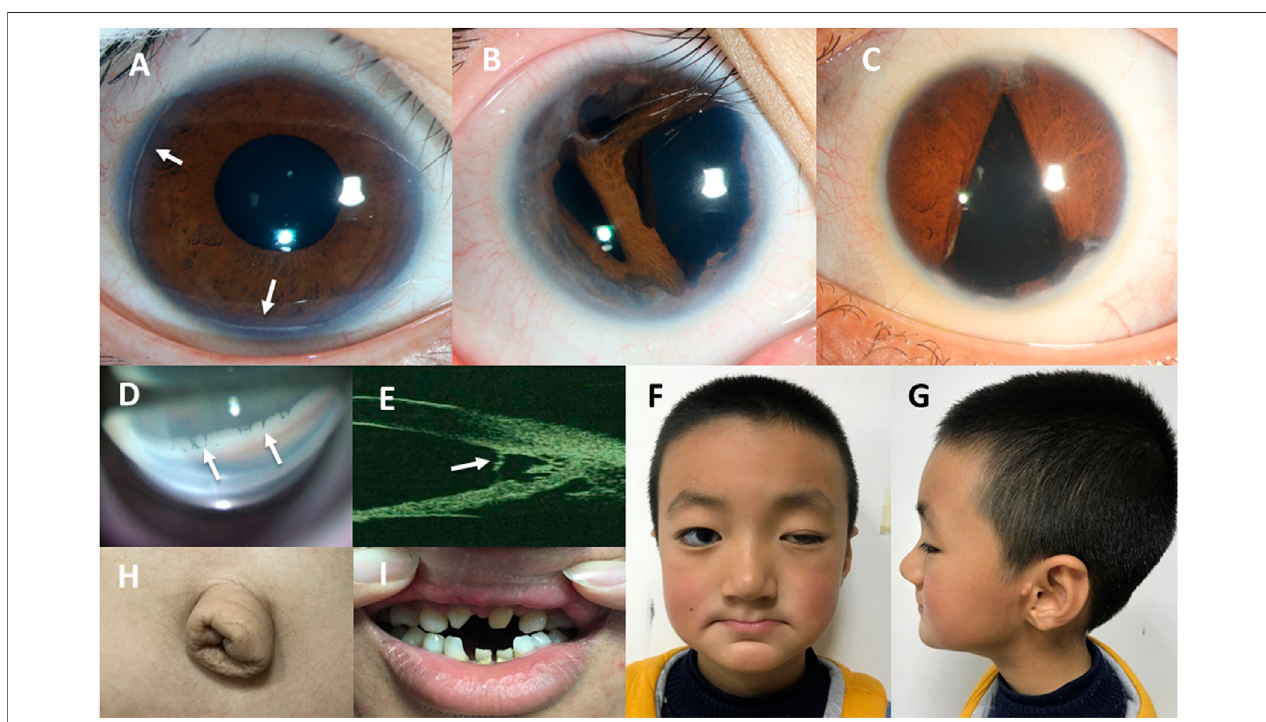
FIGURE 3 | Ocular features and systemic manifestations in our patients with ARS. (A) The anterior segment photo of patient No. 13 shows the posterior embryotoxon indicated by white arrowheads. (B) The anterior segment photo of patient No. 23 shows iris stromal hypoplasia and polycoria. (C) The anterior segment photo of patient No. 45 shows irregular pupil and corectopia. (D) The photo of anterior chamber angle under gonioscopy of patient No. 16 shows the iridocorneal adhesions across the anterior chamber angle indicated by white arrowheads. (E) The ultrasound biomicroscopy (UBM) image of the anterior chamber angle of patient No. 44 shows the iris strands bridging the iris to the posterior embryotoxon indicated by a white arrowhead. (F – H) . The photographs of patient No. 37 shows craniofacialabnormalities(abroad fl atnasalroot,maxillaryhypoplasia,thinupperlipandevertedlowerlip) (F,G) andredundantperiumbilicalskin (H) . (I) Thephotograph of patient No. 41 shows dental anomalies (hypodontia and